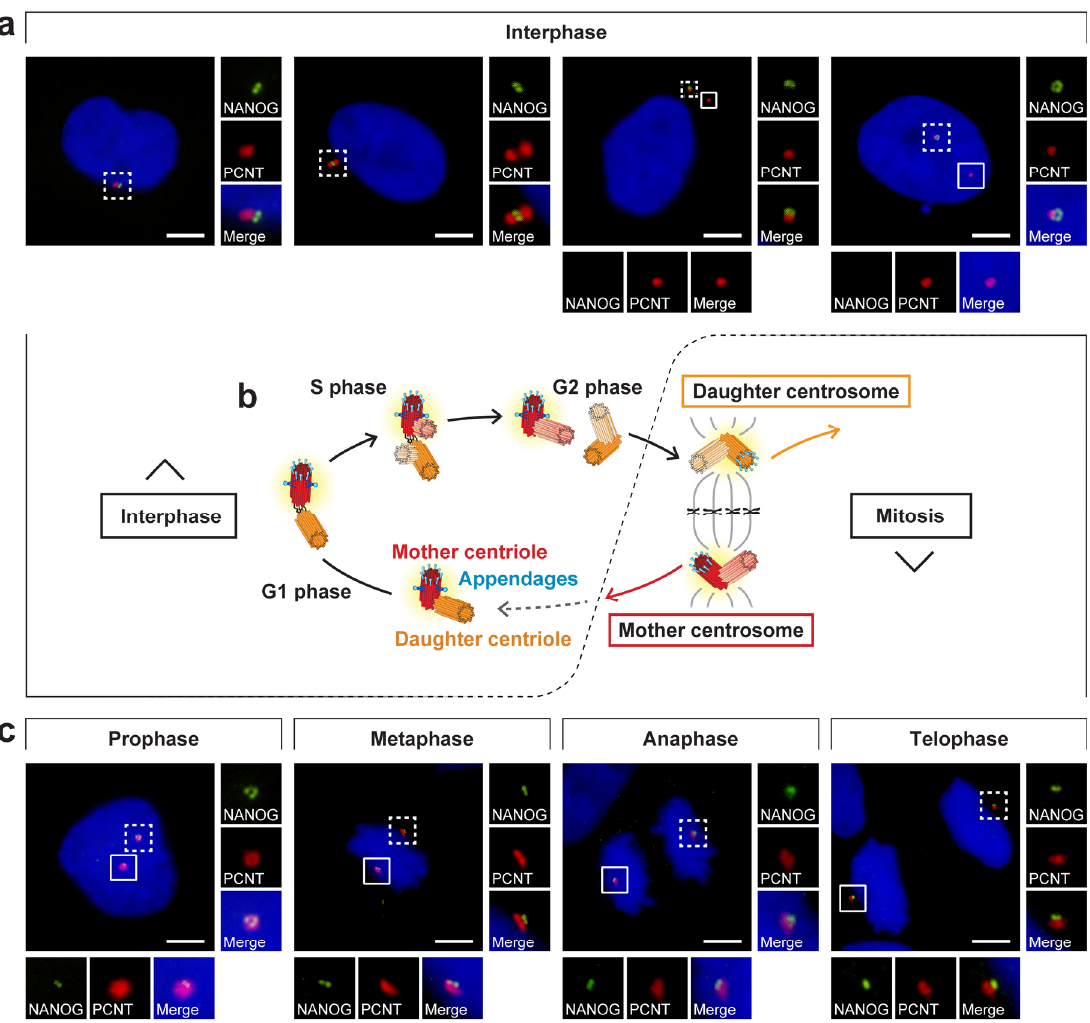
Figure 8. NANOG localization during the cell cycle. ( a , c ) Analysis of NANOG during the cell cycle by double indirect immunofluorescence. NANOG (green; #4903, Cell Signaling Technology (CST)) colocalized with one centrosome (pericentrin, PCNT; red) only during interphase ( a ) but with both centrosomes (pericentrin, PCNT; red) during mitosis ( c ). The nuclei were counterstained with Hoechst 33342 (blue). For each image, regions of interest are indicated by the dashed and solid boxes, and the close-ups are provided on the right and below, respectively. Scale bars, 5 µ m. ( b ) Schematic visualization of the centrosome duplication cycle: The centrosome is copied only once per cell cycle following cytokinesis. The centrosome duplication cycle results in two daughter cells with different ages of centrosomes: one that keeps the mother centrosome with the old mother centriole and the other cell that inherits the daughter centrosome, which comprises the young mother centriole [51,52]. Distal appendages (light blue) remain on the mother centriole during the whole cell cycle and appear during mitosis or shortly after mitosis on the older centriole of the daughter centrosome [43,53]. After mitosis, the newly formed mother centriole assembles subdistal appendages (blue) [43,53].